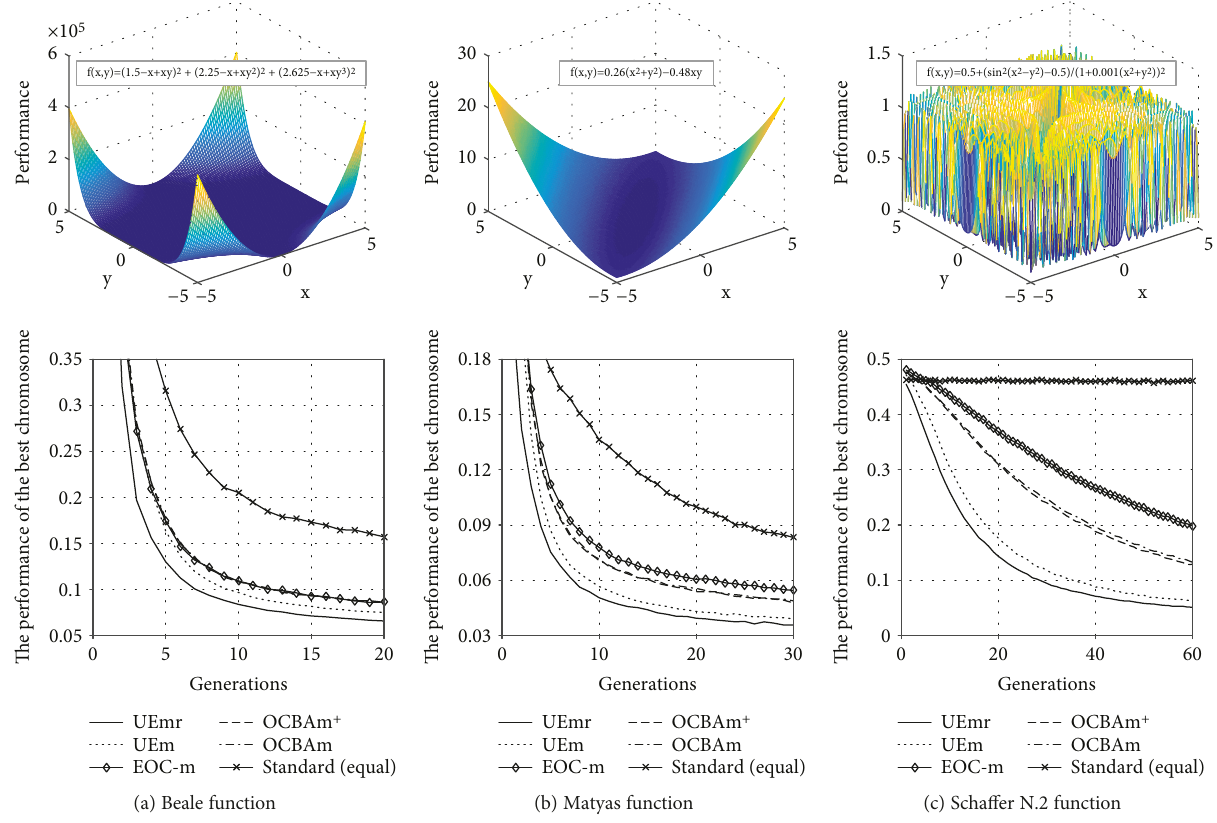
Figure 9: Comparative results of GA with various R&S algorithms on the three